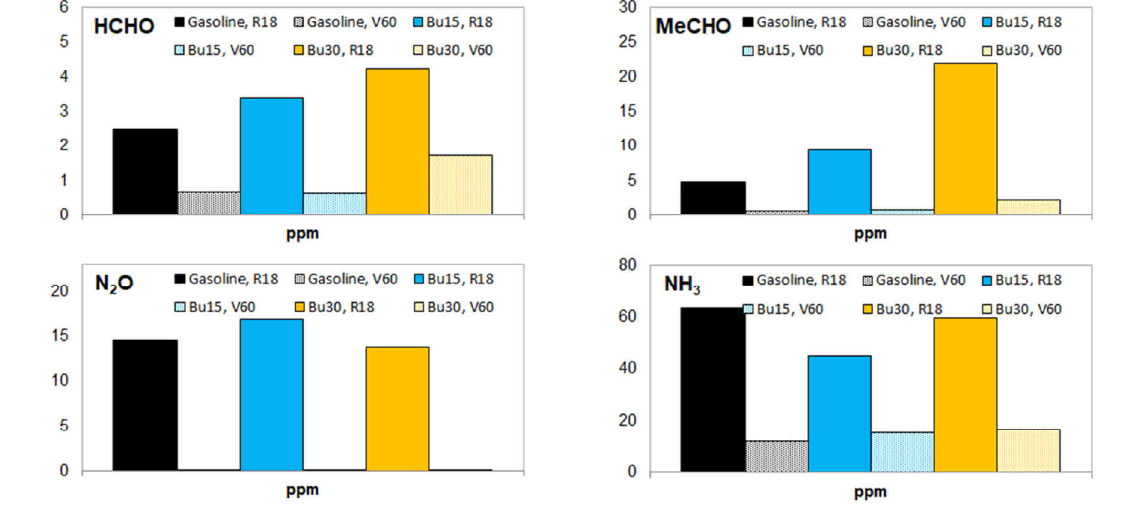
Fig. 6. Comparisons of non-legislated emissions in WLTC cold Fig. 8 illustrates the relationships of emissions at 95 km/h (in the 1st step of